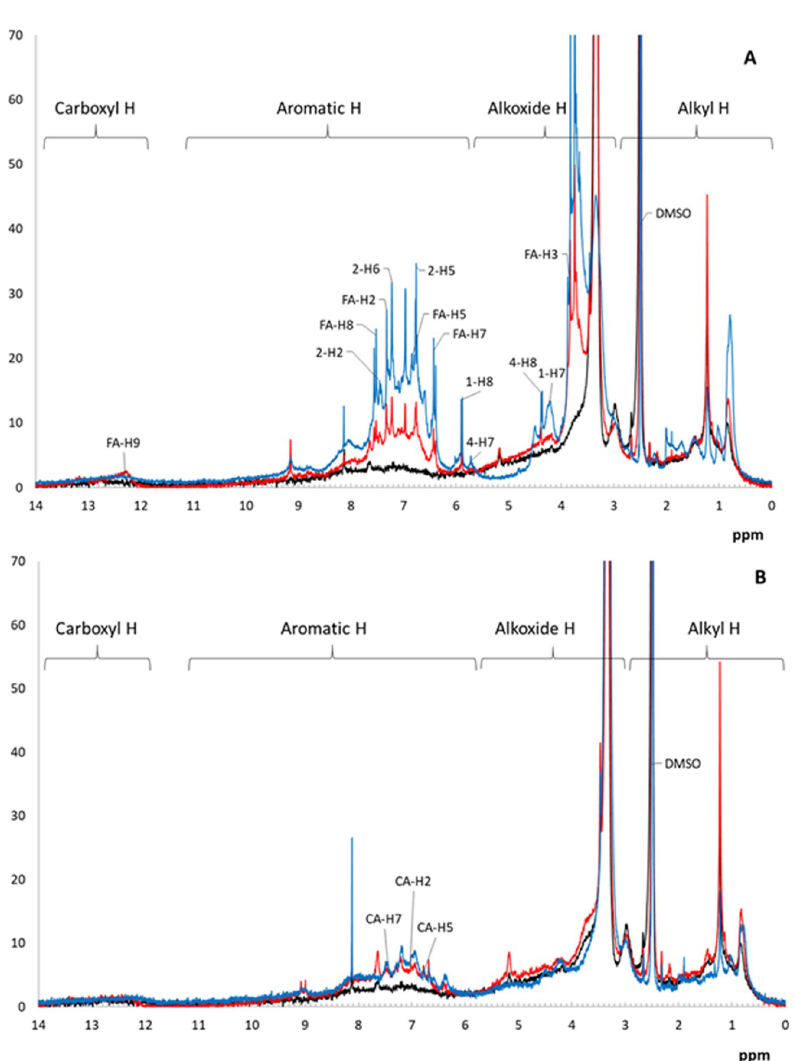
Fig 6. Solution-state 1 H-NMR spectra (in DMSO-d6) of the products of the interaction of two-domain laccase of S. puniceus (SpSL) with humic acid (HA) in the presence and absence of: (A) ferulic acid (FA); (B) caffeic acid (CA). Black line—humic acid after interaction with SpSL; blue line—phenolic acids after interaction with SpSL; red line–HA- phenolic acid mixtures after interaction with SpSL. Individual signals assigned to phenolic acids are given according to Spectral Database for Organic Compounds (https://sdbs.db.aist.go.jp/). Signals assigned to the protons of FA dimers and designations of compounds are given according to He et al (2020): 1 –FA dilactone, 2–8-8-o diferulic acid, 4 – trans-lactone acid. Structures of compounds 1, 2 and 4 are given in (He et al.,